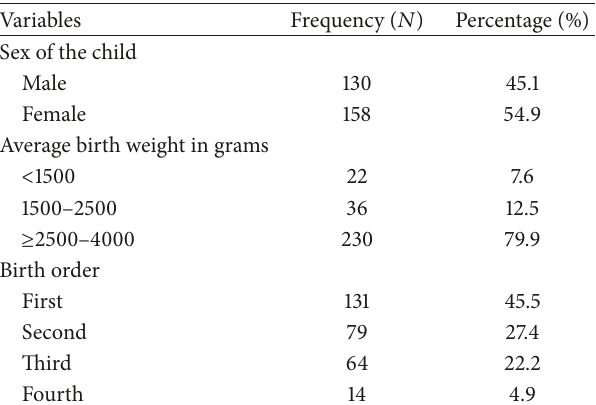
Table 2: Characteristics of children aged 12–23 months in Debre Markos town, Amhara Regional State, North West Ethiopia, September 2016. ( 𝑁 = 288 ).